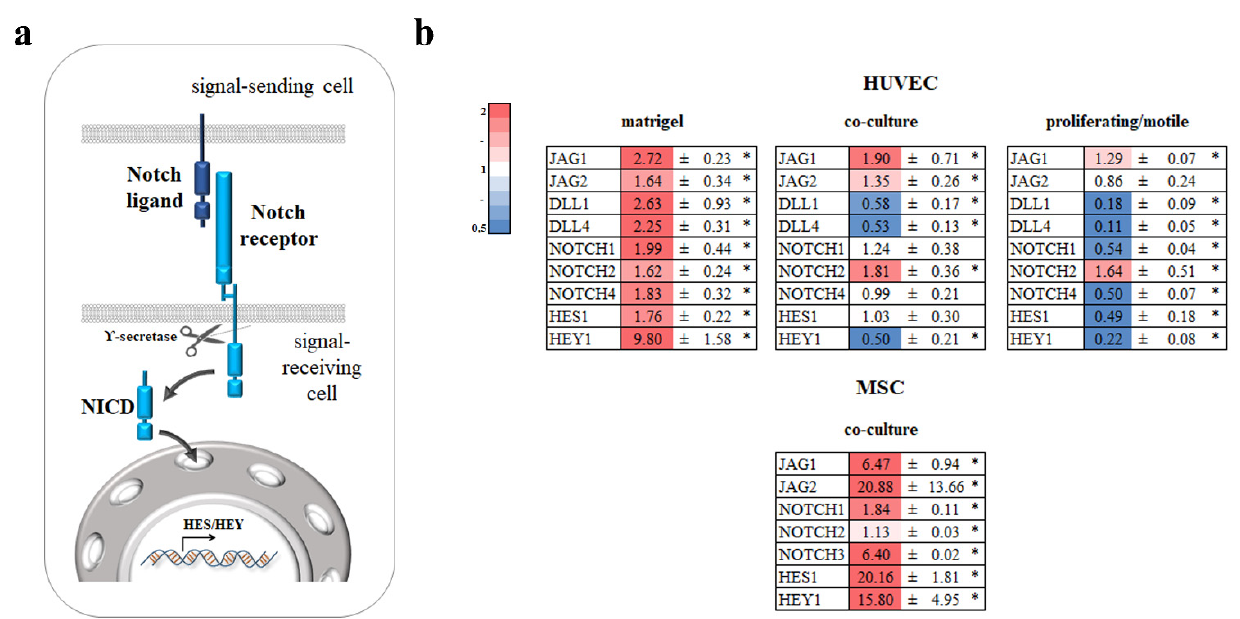
Figure 5. Analysis of Notch signaling genes. ( a ) Scheme illustrating Notch signaling. ( b ) HUVECs were grown on Matrigel TM , in co-culture with MSCs, or as proliferating/motile HUVECs or a confluent monolayer for 19 h. Cells in direct co-culture were separated using anti CD31 magnetic beads. Total RNA was isolated and specific mRNA levels were quantified by qRT PCR as described in “Methods”. The data are presented as fold changes in the mRNA levels of HUVECs on Matrigel TM , in co-culture with MSCs, proliferating/motile HUVECs compared to the mRNA levels for the same transcript in confluent monolayer, or to a monoculture for MSCs “*”: p < 0.05, n ≥ 3.